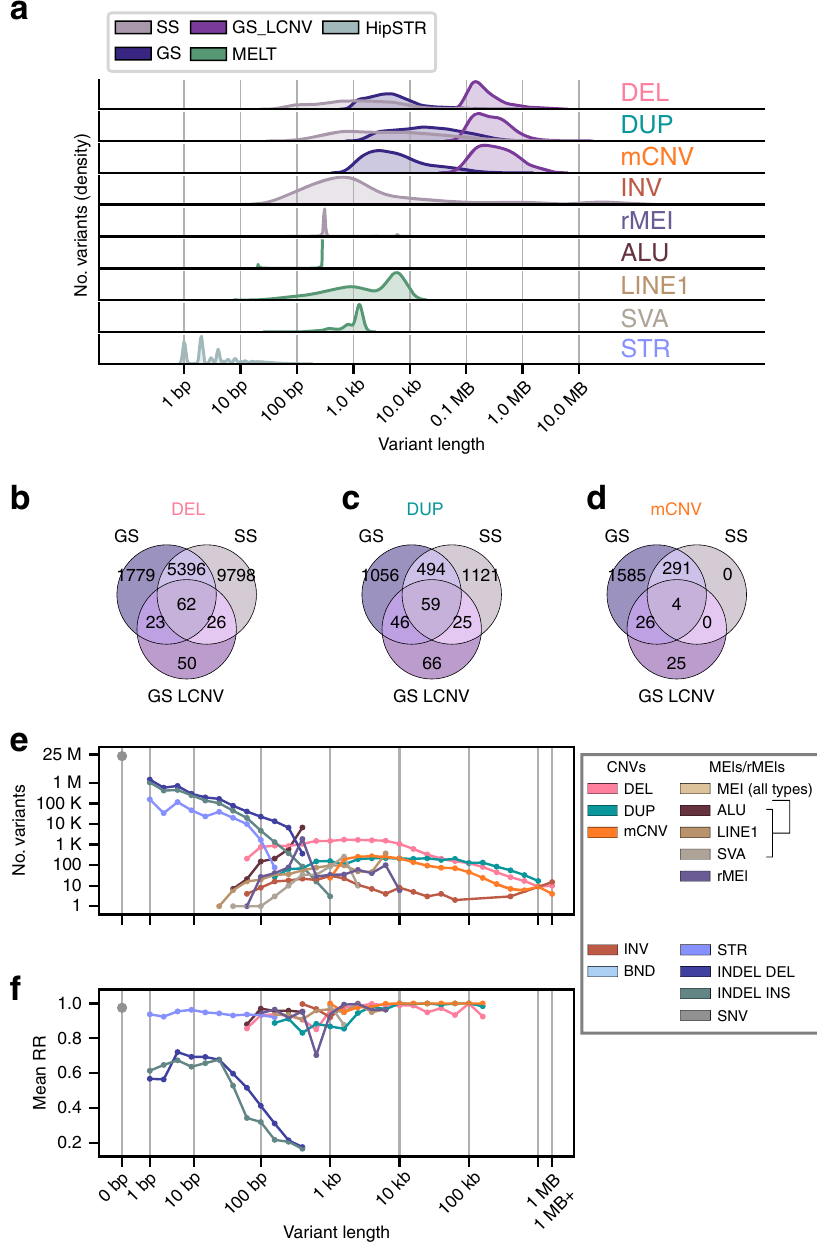
Fig. 3 Variant length distributions and variant caller comparison. a Density plot showing the size spectrum of each variant caller before identifying multi- caller clusters. b – d Number of overlapping variants after identifying multi-caller clusters for deletions ( b ), duplications ( c ), and mCNVs ( d ). e Number of variants in the non-redundant call set separated by variant class and grouped in log linear bins by variant length. Points are drawn at the upper limit of each bin (e.g. a bin from 50 to 100 bp is drawn at 100 bp). For STRs length represents the maximum number of bases different from the reference at each site (largest insertion or deletion observed). f The average replication rate of variants segregating in the 25 monozygotic twin pairs is represented for each length bin that contains at least 10 variants. GATK SNVs and indels previously discovered in iPSCORE samples 40 were used for e and f